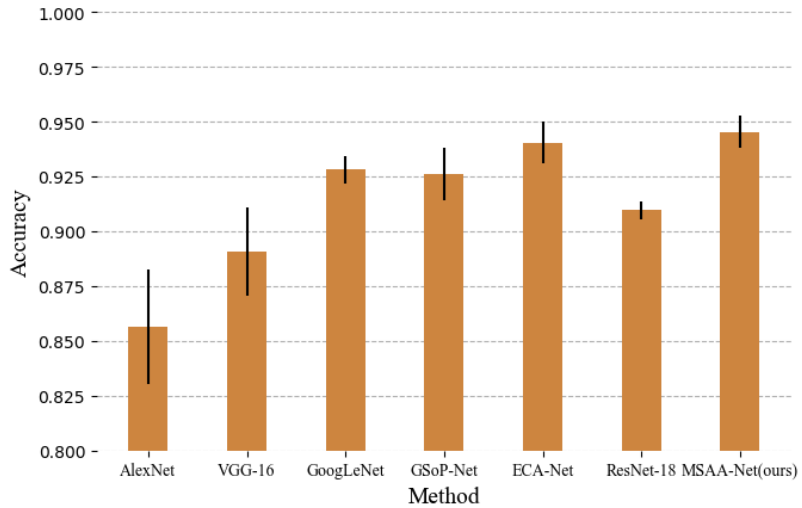
Figure 9. Classification results of different methods for the UC Merced dataset.